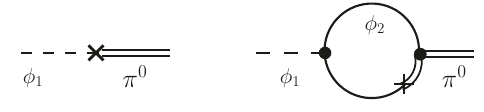
Figure 7 . The leading order and one loop induced (cid:30) 1